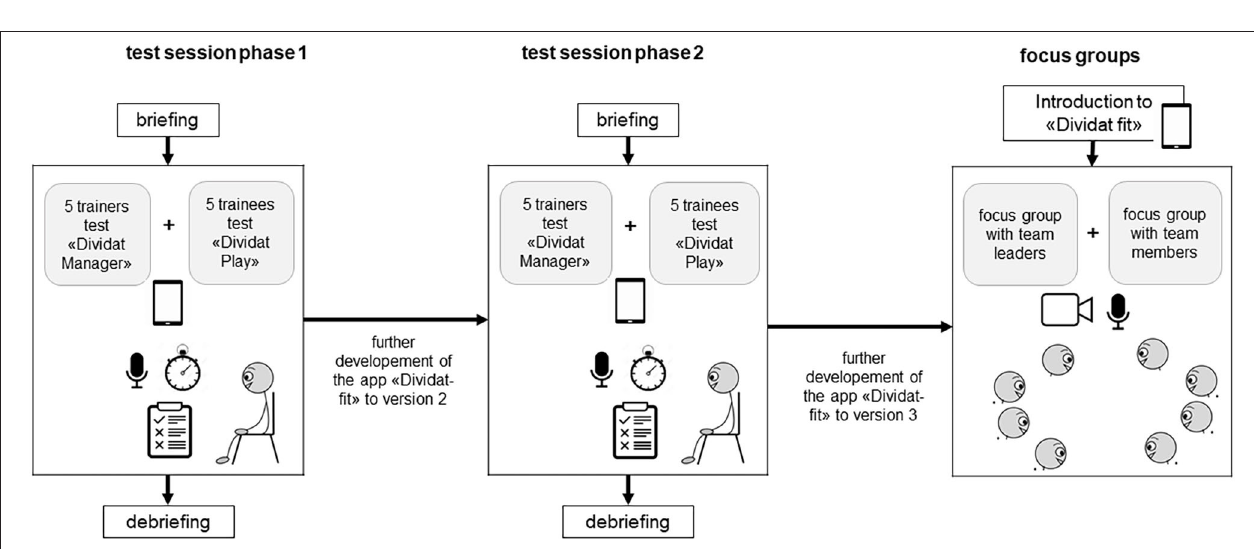
FIGURE 3 | Usability